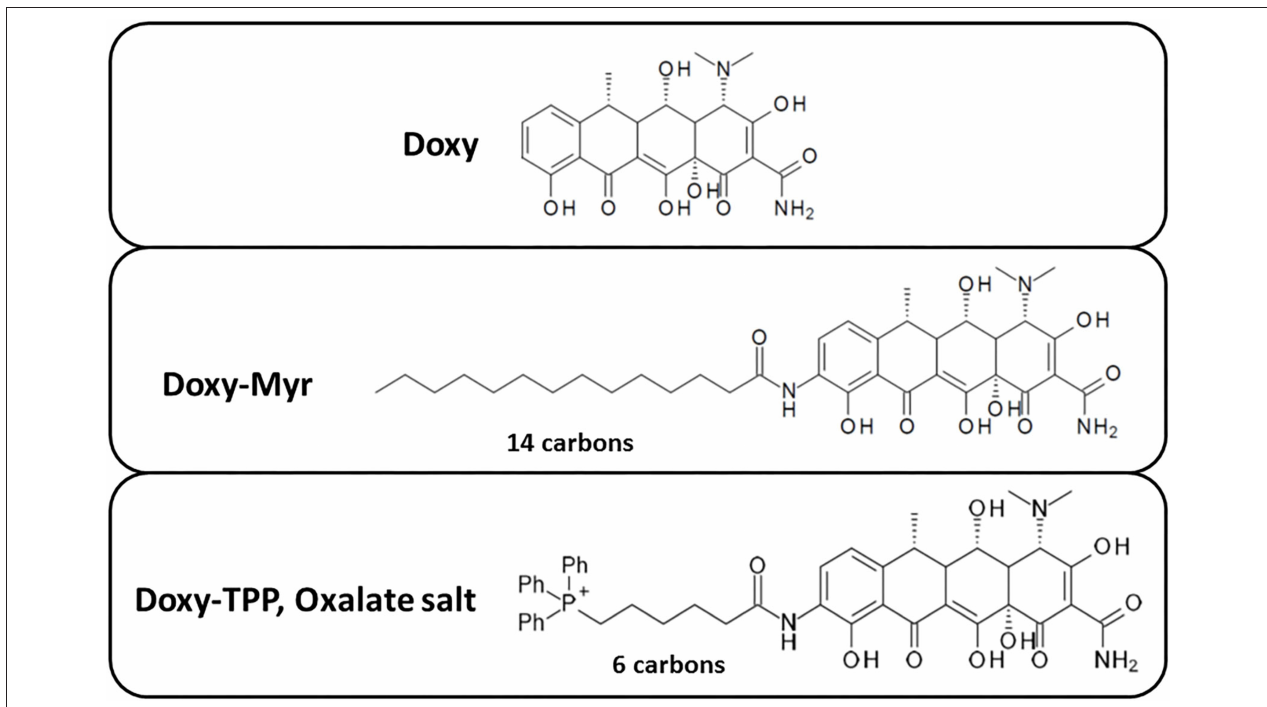
FIGURE 1 | Chemical structures of two new Doxycycline derivatives: Doxy-Myr and Doxy-TPP. Note that Doxy-Myr contains a 14-carbon fatty acid (myristate) covalently attached to 9-amino-Doxycycline and Doxy-TPP contains a TPP-moiety attached via a 6-carbon spacer to 9-amino-Doxycycline.